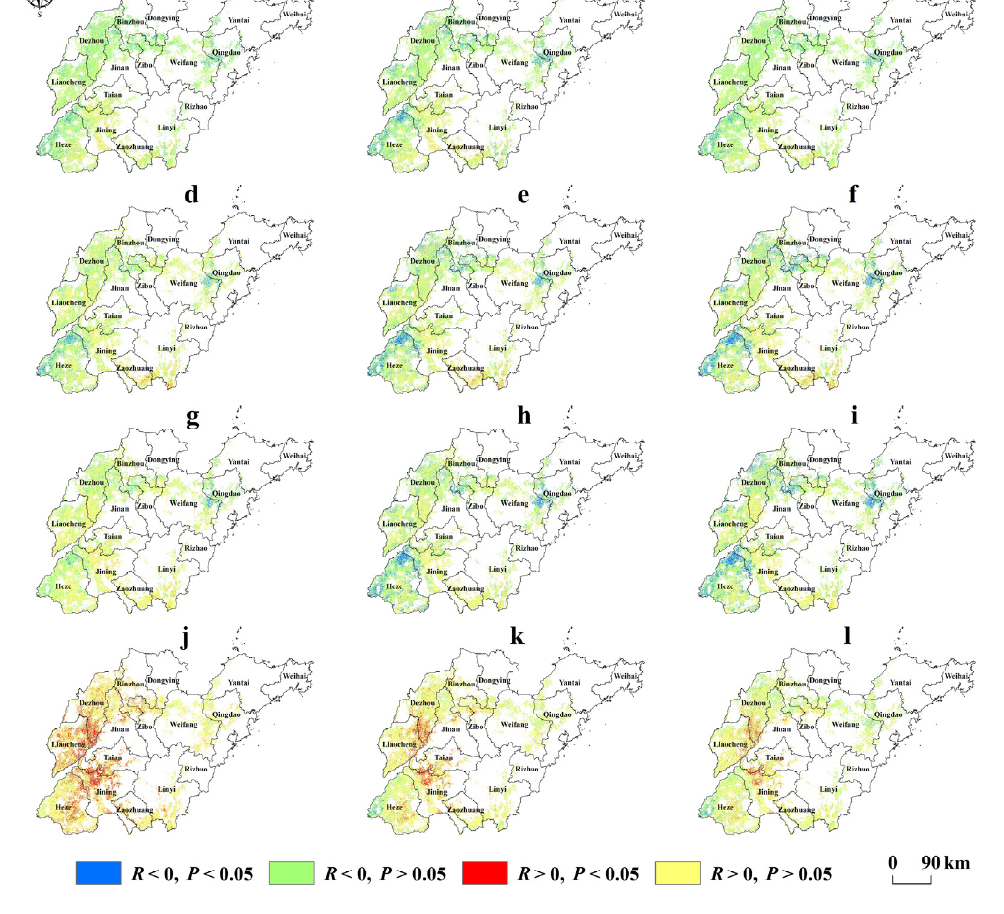
Figure 11. ( a – l ) Same as Figure 9 but for maximum temperature. Winter wheat green-up date with 69.30%, 63.94%, and 73.62% of the pixels presented a negative relevance with T max1 (Figure 11a), T max2 (Figure 11b), and T max3 (Figure 11c), and 6.31%, 8.70%, and 5.59% passed the significance test at the 0.05 level, respectively, which were mainly located in the West of Shandong Province as well as parts of winter wheat growing areas in Qingdao and Weifang. In nearly 51.61%, 54.92%, and 54.48% of the pixels a negative correlation between jointing date and T max1 (Figure 11d), T max2 (Figure 11e), and T max3 (Figure 11f) was found of which 5.09%, 9.15%, and 11.03% passed the significance test at p < 0.05, respectively. The pixels presented a significant negative correlation mainly distributed in the Northwest of